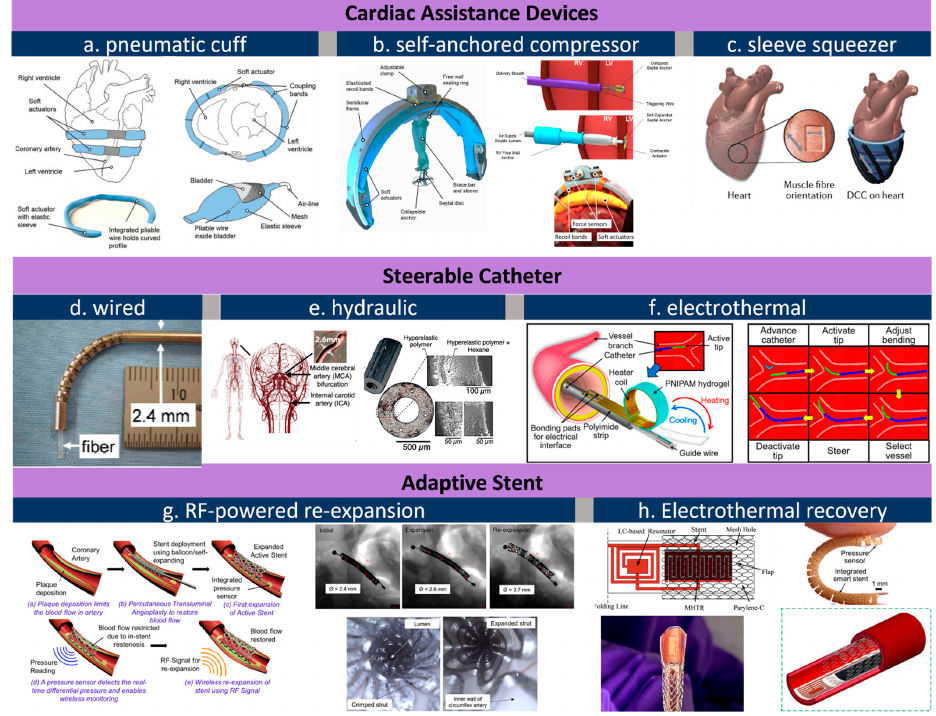
Figure 2. Actuators for cardiovascular applications. ( a ), pneumatic cuff that is wired to heart’s contour [41]; ( b ), a self-anchored assistance-squeezer [42]; ( c ), a pneumatic sleeve for twist-n-squeeze actuation [24]; ( d ), steerable catheter through wired control [44]; ( e ), a fluid-steered catheter [45]; ( f ), electrother- mally controlled steering of catheter tip [43]; ( g ), RF-triggered re-expansion against restenosis concept (left) and its in vivo image before and after RF expansion (right) [87]; ( h ), electrothermal treatment of restenosis [89]. All images are reproduced or adapted with permission.